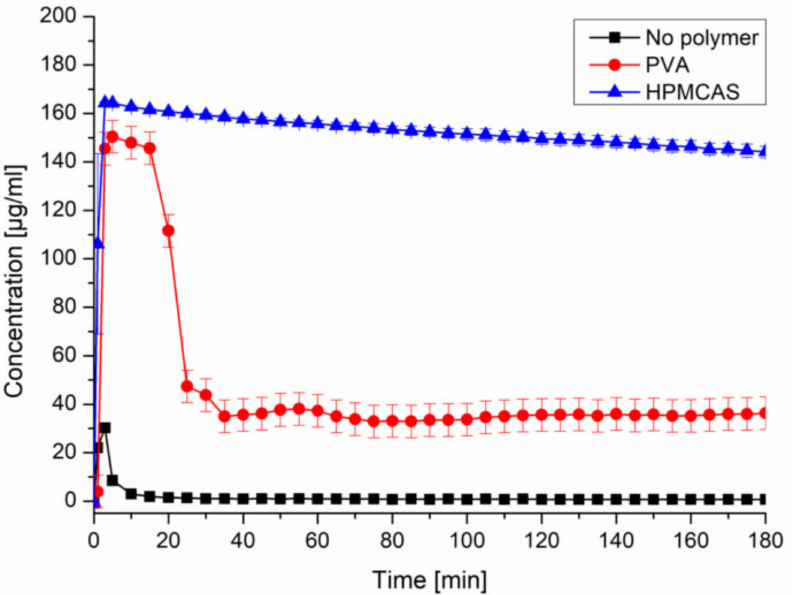
Figure 2. Supersaturation assay of CXB in PBS at pH 6.8 and in presence of predissolved PVA or HPMCAS